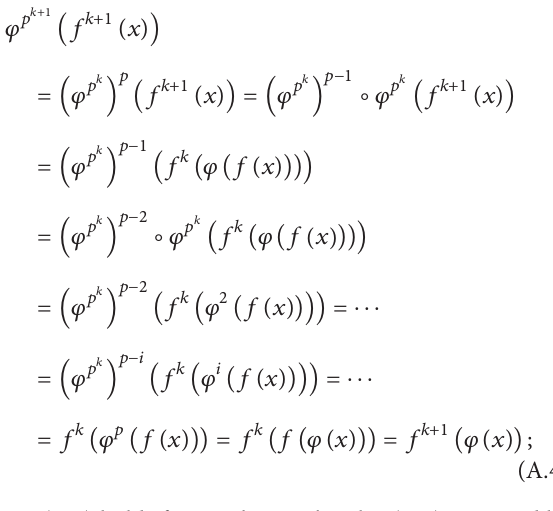
Figure 1: The graph of non-single-valley solution.